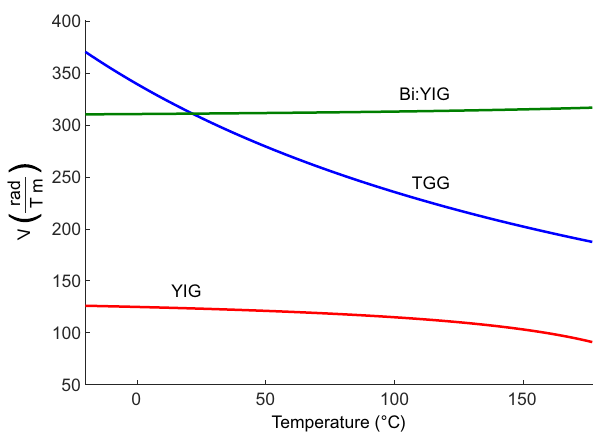
FIG. 8. The temperature dependence of the Verdet constant for TGG, YIG, and Bi:YIG at 1550 nm wavelength.